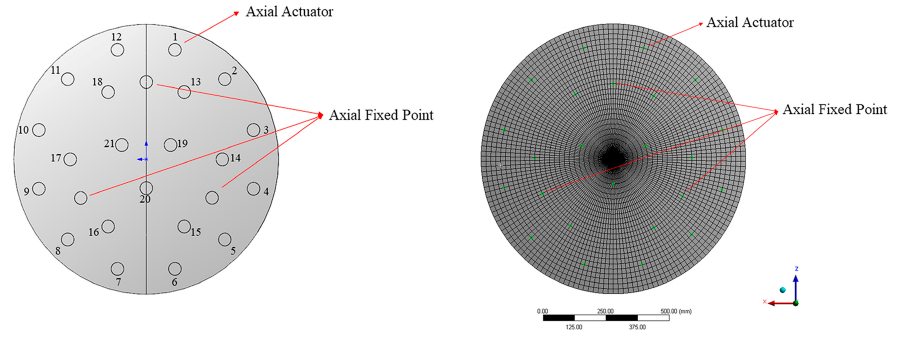
Figure 1. The support system of the standard mirror and finite element analysis.